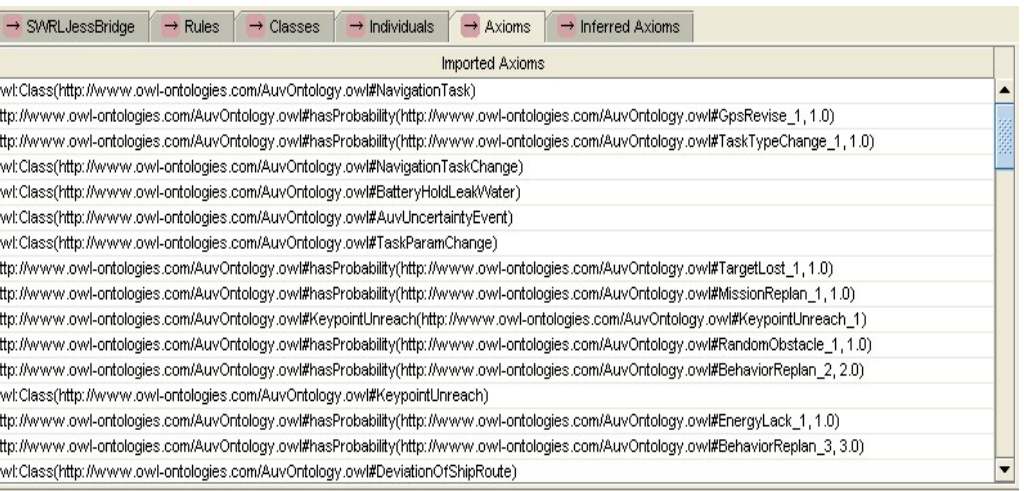
Figure 4. Flow chart of uncertainty event detection.